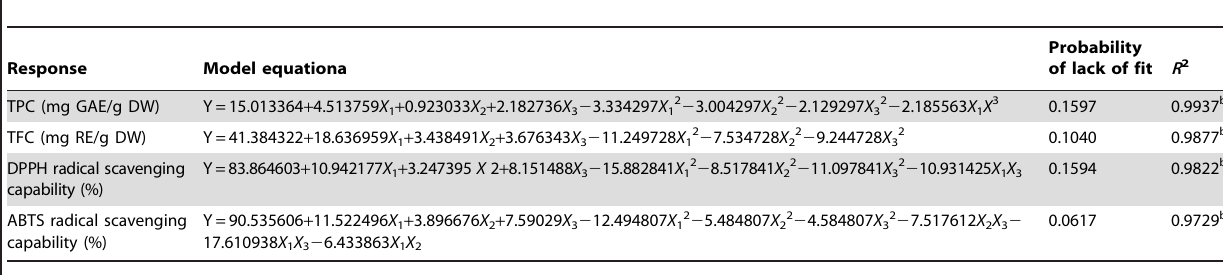
Table 2. Regression models fitted to the experimental data of response